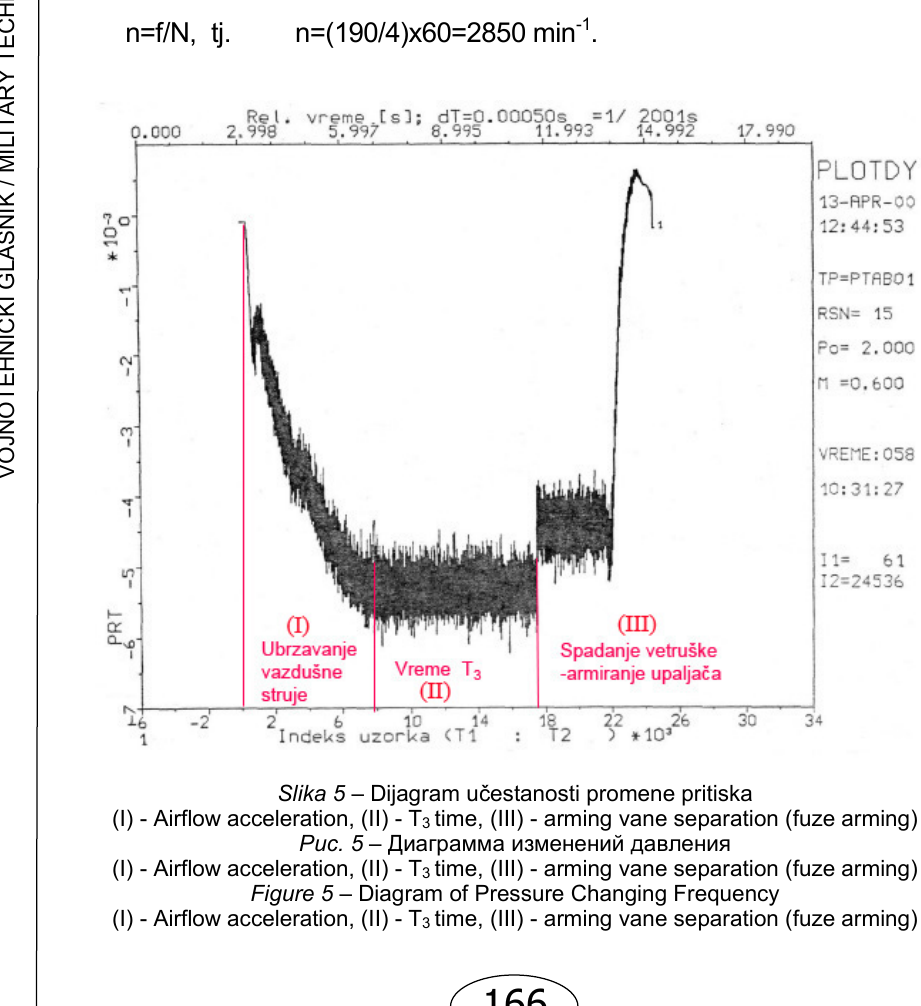
ške N=4 daje broj obrtaja vetruške n: n=f/N, tj. n=(190/4)x60=2850 min -1 .